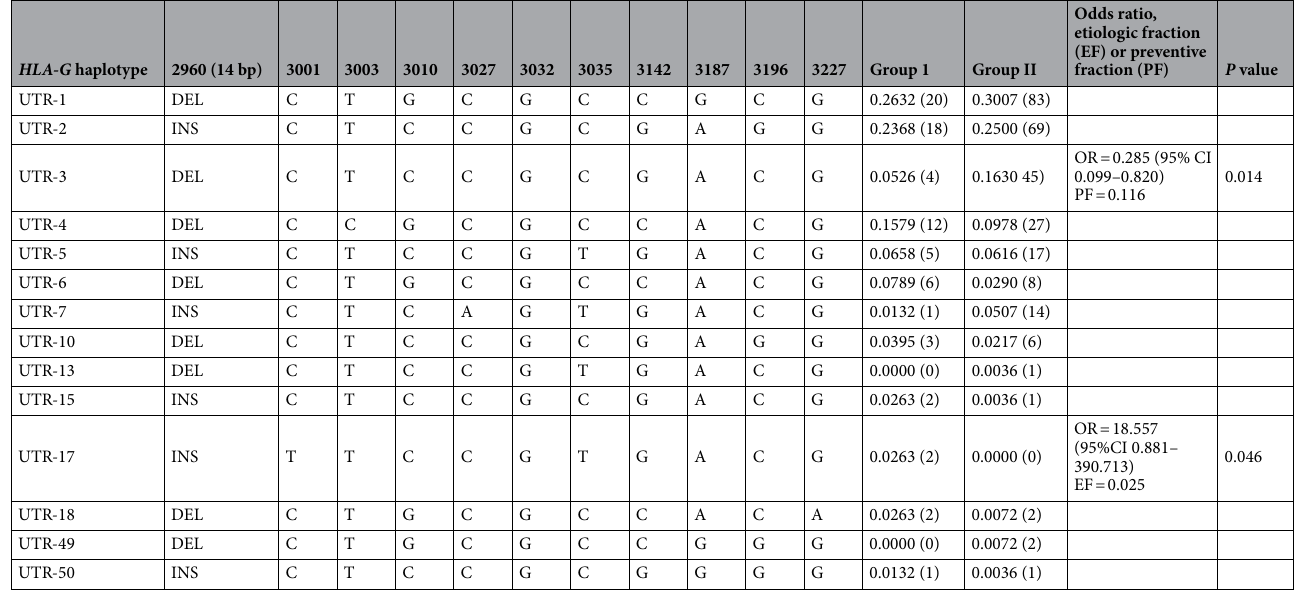
allele, and they were all associated with susceptibility to CMV-R. The + 3001C/T variable site is uncommon in healthy Brazilian individuals, but has been encountered in African populations 24 . This allele was also associated